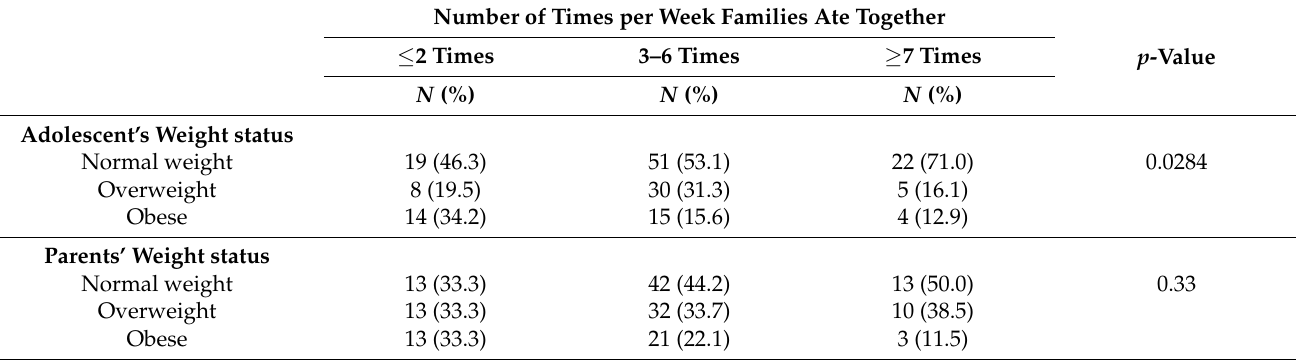
Table 7. Relationship between weight status of adolescents and family meal frequency. Number of Times per Week Families Ate